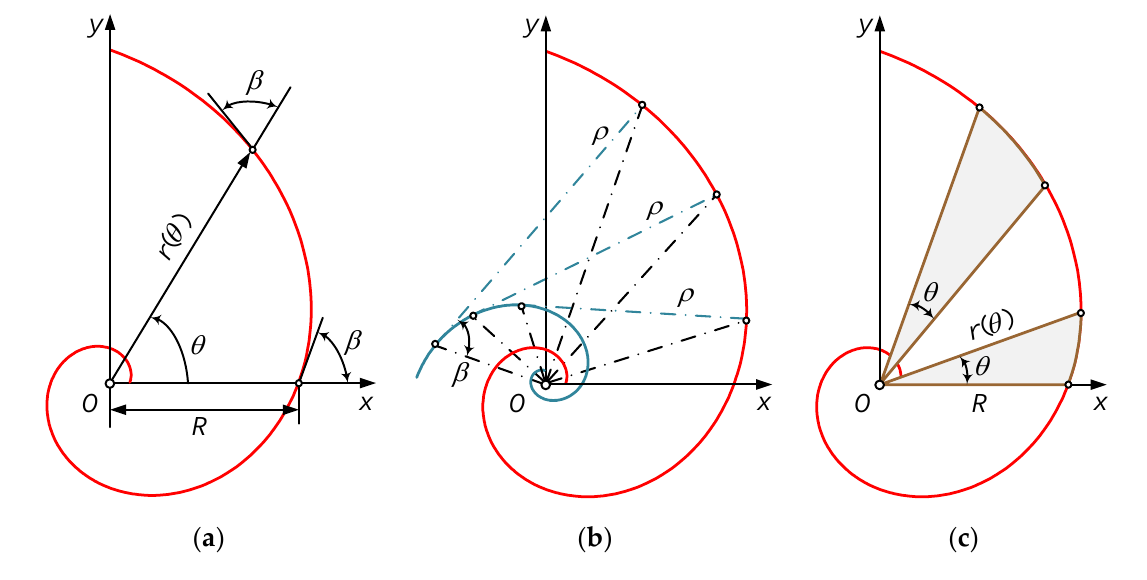
Figure 4. Logarithmic spiral. ( a ) equiangularity; ( b ) evolute; ( c ) similarity.